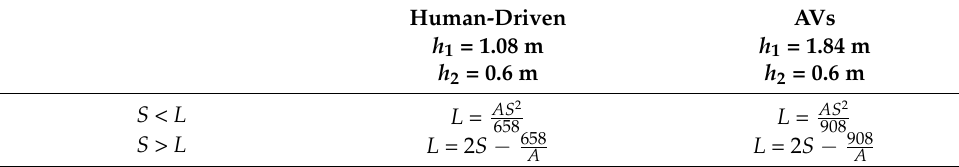
Table 3. Formulas for calculating the crest curve length for human-driven vehicles and AVs.